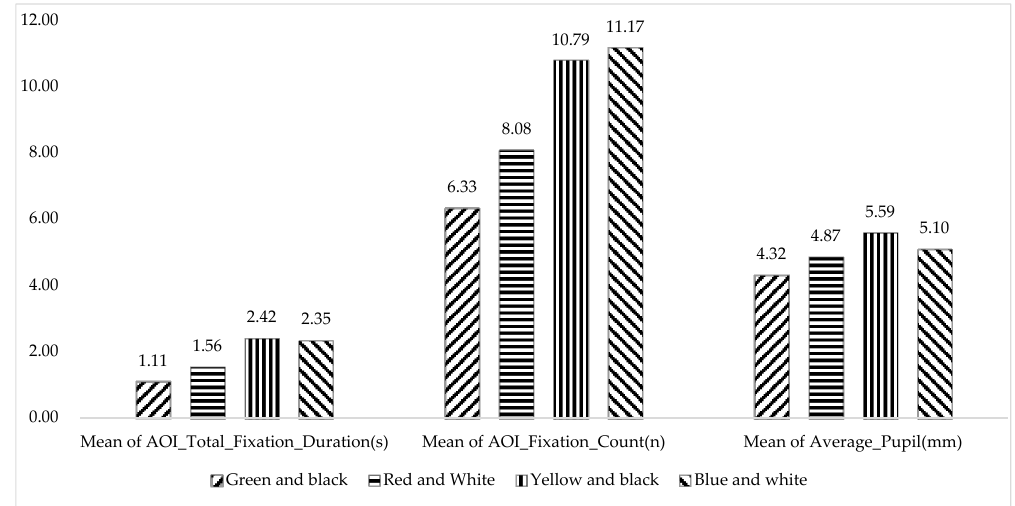
Figure 9. Mean of AOI_Total_Fixation_Duration, mean of AOI_Fixation_Count, and mean of Average_Pupil in the four color groups.